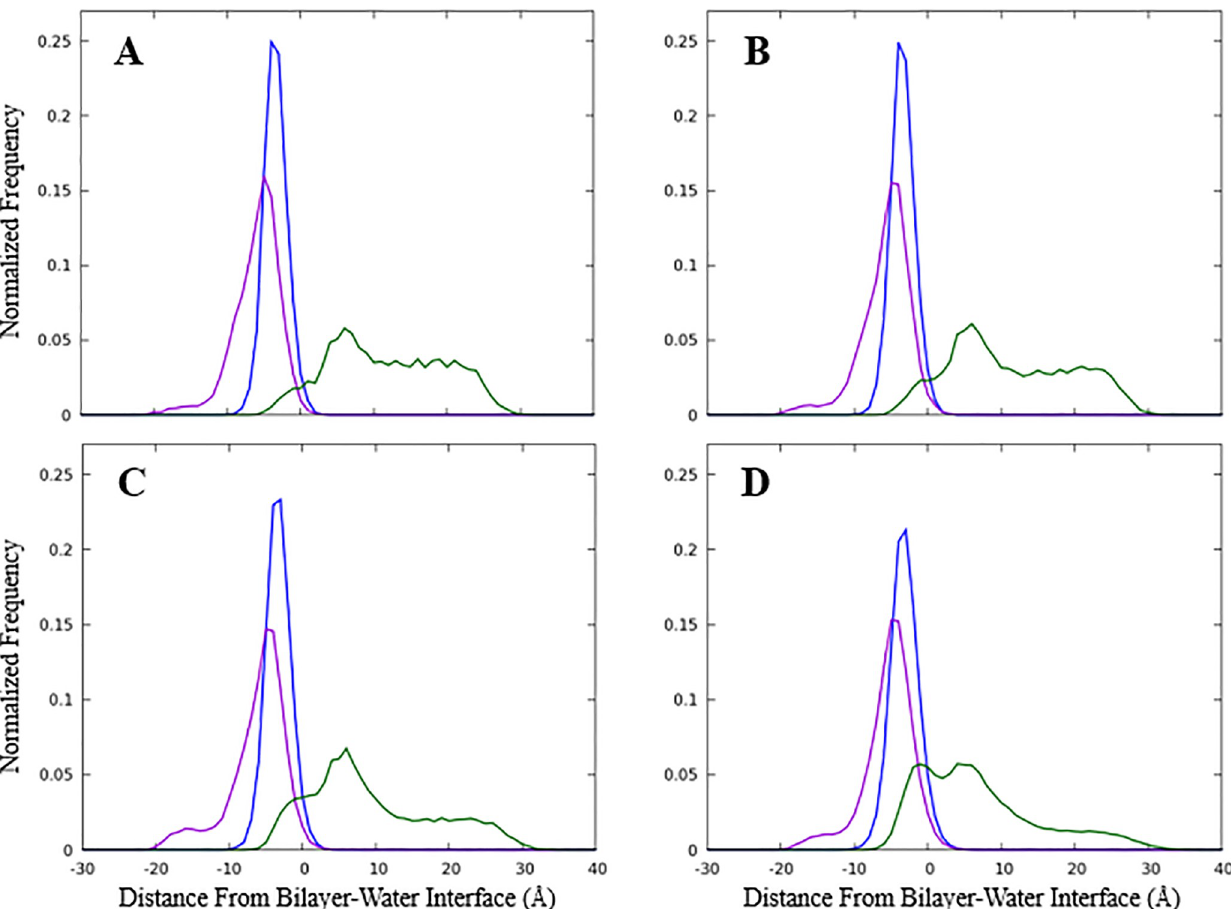
Fig 6. Probability distribution of CAGE components into a model membrane. Simulations defined the probability distribution of components perpendicular to the average bilayer surface with A) 8 CAGE, B) 16 CAGE, C) 32 CAGE, or D) 64 CAGE components added. The cholinium cation density is shown in green, geranate in blue, and geranic acid in purple. The zero point is the average position of the phosphorus atom from each lipid in the leaflet, where negative values are within the bilayer and positive values are in the aqueous phase. Results from each leaflet are averaged to improve statistics.